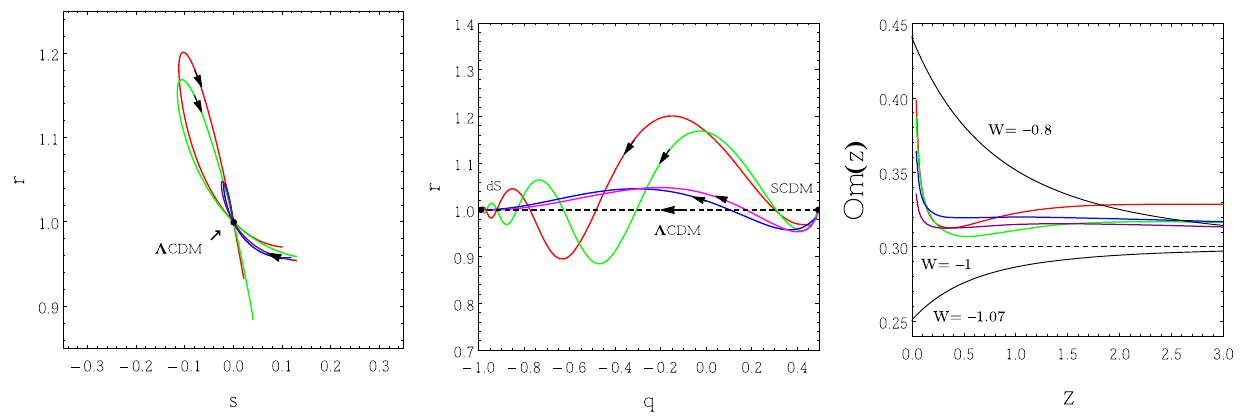
SCDM and converge to dS. The horizontal dashed line corresponds to (cid:2) CDM. In the right panel, we show the evolution of Om ( z ) ver- sus z for (cid:2) CDM (w = − 1 ) , quintessence (w = − 0 . 8 ) and phantom (w = − 1 . 07 ) , and also for potential (1) with n > 1. The evolution of Om ( z ) for n > 1 has negative curvature which is compatible with the analytical solution